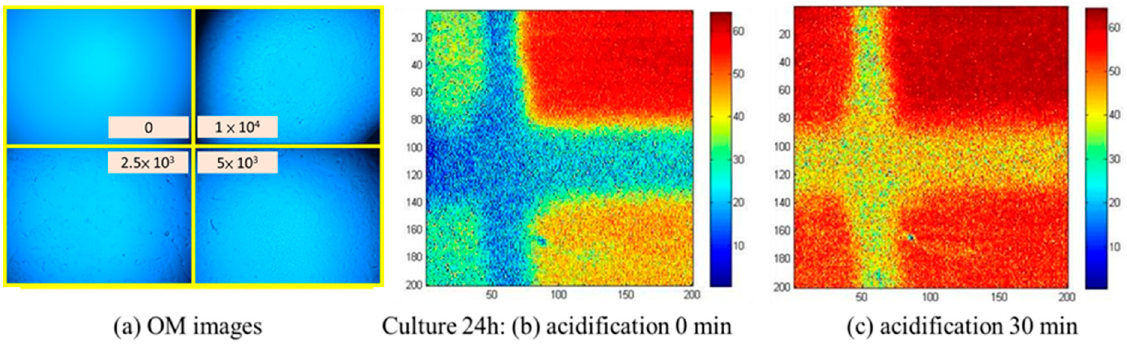
Figure 3. ( a ) OM images, ( b ) cultured for 24 h and ( c ) acidification for 30 min in HBSS solution of cell directly culture on Si3N4 LAPS surface with different cell